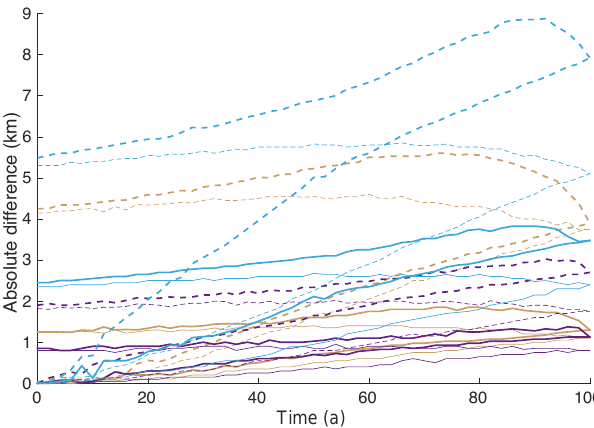
Figure 3. Influence of lateral resolution from experiment MIS- MIP3d P75S and P75R: evolution of the absolute differences in kilometres between the highest resolution ( N y = 80) and the two others ( N y = 40 continuous line and N y = 20 dashed line) for the three different methods: LG (brown), DI (purple) and FF (blue), on the symmetry axis ( y = 0; thick curves) and on the free-slip bound- ary ( y = 50km; thin curves). The initial results used to plot this figure are presented in Figs. S4, S5 and S6 for lateral resolutions N y = 20, N y = 40 and N y = 80,